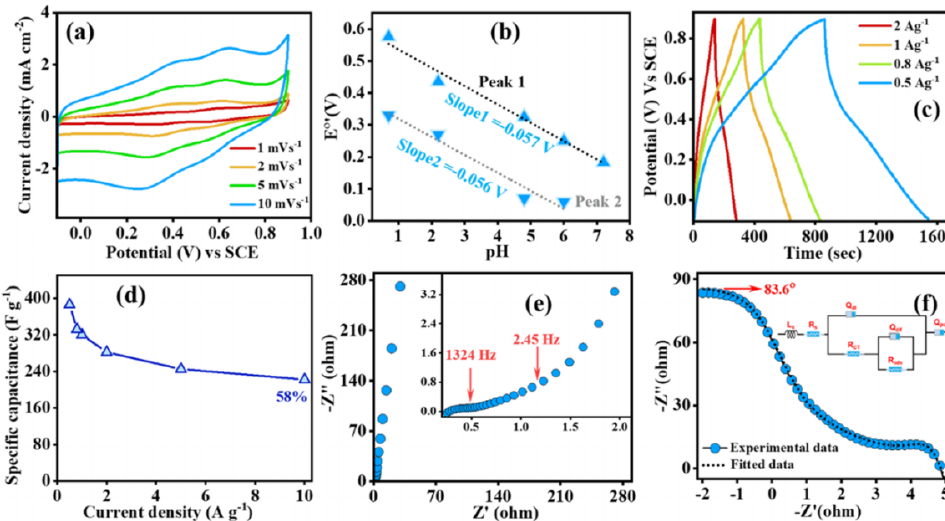
Figure 10. ( a ) The CV curve at different scan rates and ( b ) the Pourbaix diagram of HRFG in a three-electrode system. ( c ) The GCD and ( d ) specific capacitance under different current densities. ( e ) The Nyquist plot and ( f ) the Bode plot of HRFG; inset equivalent circuit. Reprinted with permission from [84]. Copyright (2022) American Chemical Society.